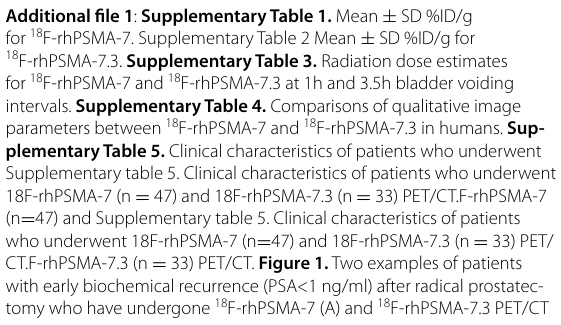
33) PET/CT.F‑rhPSMA‑7 =